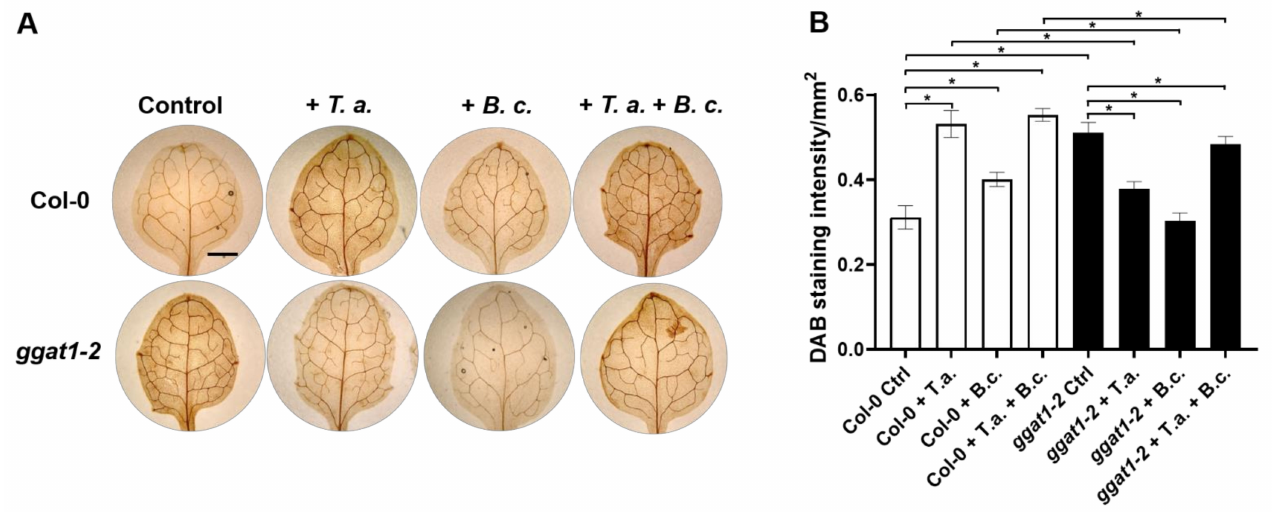
Figure 8. Histochemical detection of H 2 O 2 in Arabidopsis leaves by DAB staining. ( A ) H 2 O 2 in Arabidopsis leaves was visualized by DAB staining. Three leaves of each 12-day-old Col-0 or ggat1-2 seedlings were inoculated with B. cinerea or with inoculation buffer as controls from plants previously treated (+ T. a . + B. c. ) or not with T. atroviride (+ B. c .). The histochemical detection of H 2 O 2 in uninoculated leaves was evaluated one-day post-inoculation with the phytopathogen. Leaves infiltrated with buffer were included as controls (not shown). Pictures were taken at 4x magnification in a microscope (ZEISS Primostar). Representative leaves from 10 plants are shown. The experiments were repeated twice with similar results. Scale bar, 1 mm. ( B ) DAB staining intensity as determined with Fiji, an image processing package distributed by ImageJ software (https://imagej.net/Fiji, accessed on 29 May 2021). The data represent the means of 10 leaves from each condition. Results were analyzed using a Tukey multiple comparison test ( α = 0. 05). Asterisk indicates p < 0.05. Error bars indicate